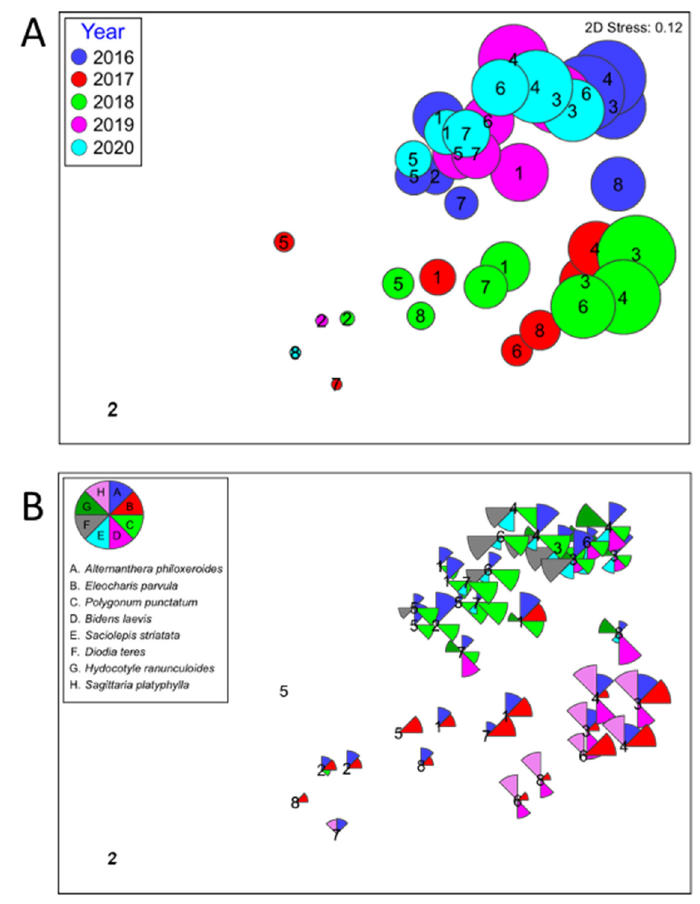
Figure 14. Percent cover of ( A ) all species and all years (bubble size represents relative total cover) and ( B ) the same ordination showing only the eight dominant herbaceous species ( Alternanthera philoxeroides , Bidens laevis , Diodia teres , Eleocharis parvula , Hydrocotyle ranunculoides , Polygonum punctatum , Sagittaria platyphylla , and Sacciolepis striata ). Pie slices reflect relative percent cover of the individual species.